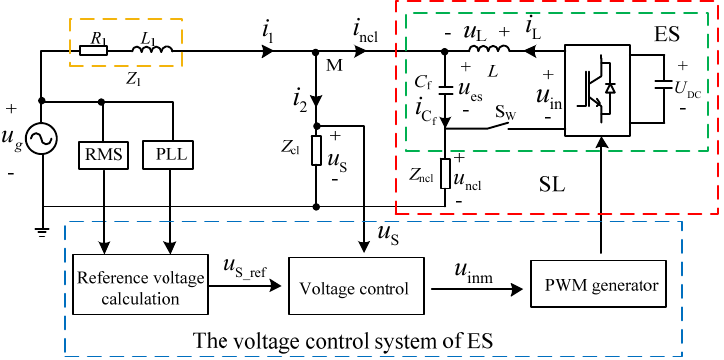
Figure 2. Typical circuit with ES and control block diagram. The blue dotted frame contains the ES control system, in which the module for cal- culating the reference voltage calculates the CL reference voltage u S_ref from u g and the system parameters. According to u S and u S_ref , the voltage control module generates a pulse–width modulation wave to control the on-off inverter switch tube, thereby adjusting the output voltage of the ES to stabilize the root-mean-square (RMS) voltage of u S at a preset value. According to u g , the ES works in one of three modes: inductive, resistive, and capacitive. When u es = 0, ES works in resistive mode and does not exchange reactive power with the grid. The RMS of u g at this point is denoted U g_ref . When the RMS of u